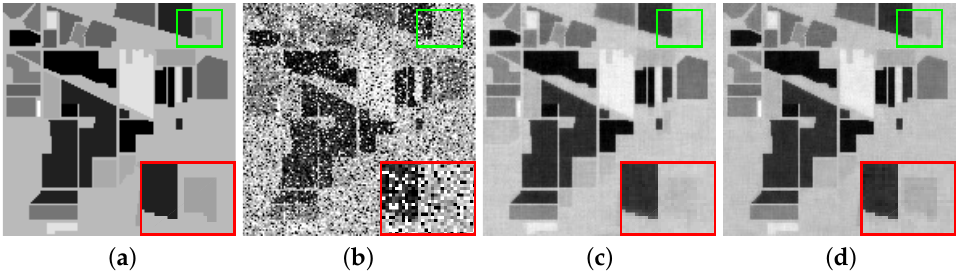
Figure 8. ( a ) Original image, ( b ) noisy image, image denoised by ( c ) 3DTNN, ( d ) ours of band 26 in the dataset-2, noise case 2.